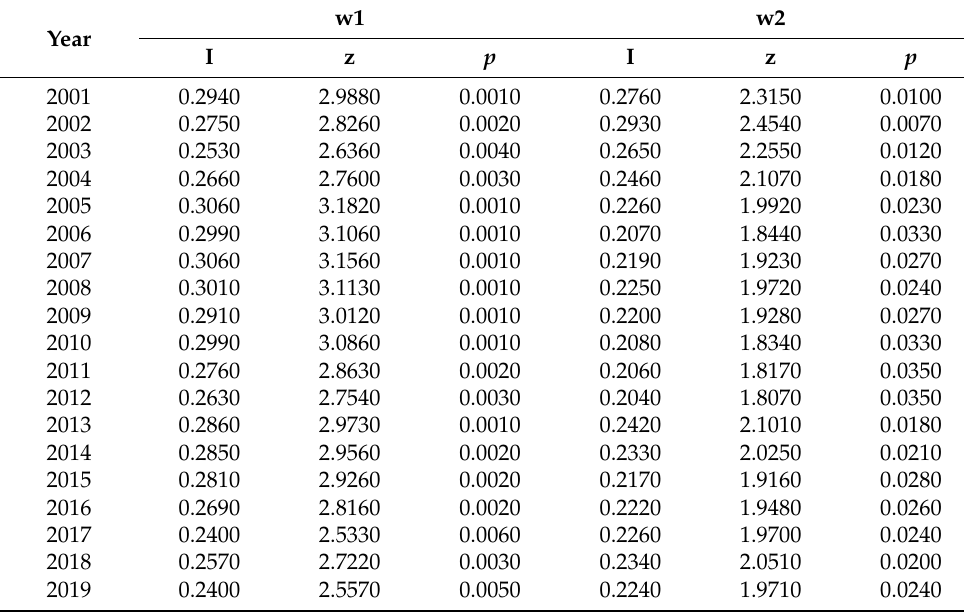
Table 4. Calculation results of the global Moran’s I values of CE,